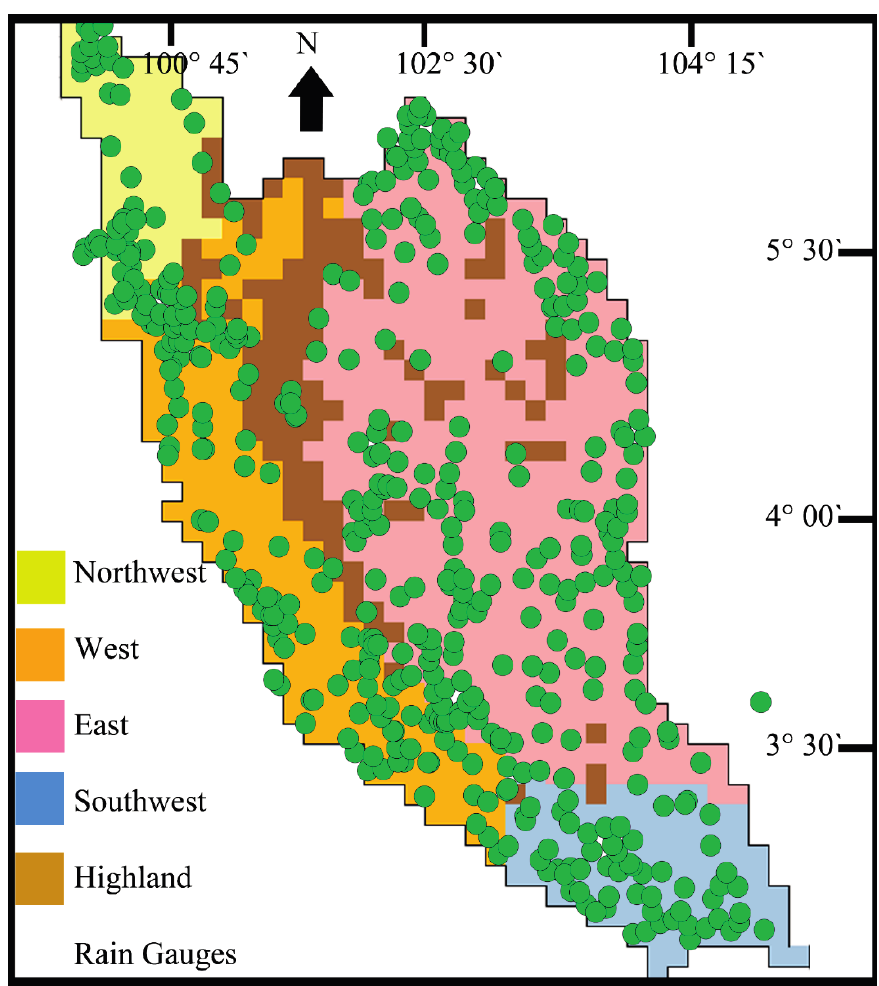
Figure 2. Peninsular Malaysia climate region at 0.125 degrees and distribution of rain